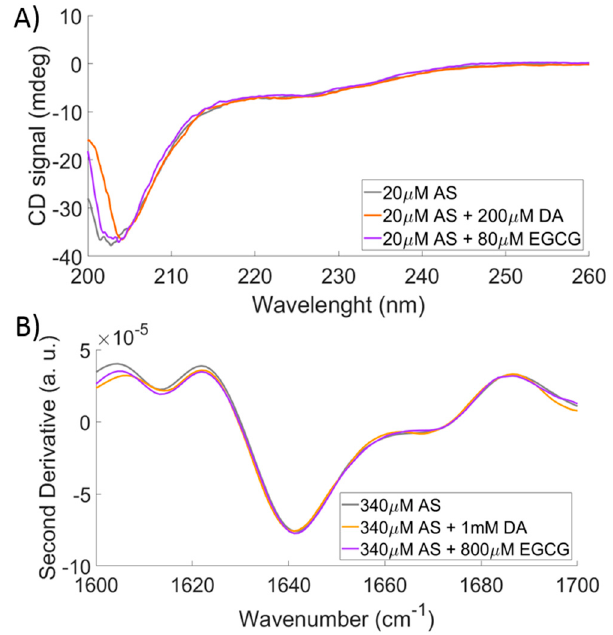
Figure 3. Secondary-structure content as obtained by CD and Fourier-transform infrared spectroscopy (FTIR) techniques. ( A ) Far-UV CD spectra of 20 μ M AS in PBS buffer in the absence of ligands (gray), in the presence of 200 μ M DA (orange) or 80 μ M epigallocatechin-3-gallate (EGCG) (purple). ( B ) Second derivatives in the Amide I region of the FTIR absorption spectra of 340 μ M AS in deuterated PBS buffer in the absence of ligands (gray) and in the presence of 1 mM DA (orange) or 800 μ M EGCG (purple).